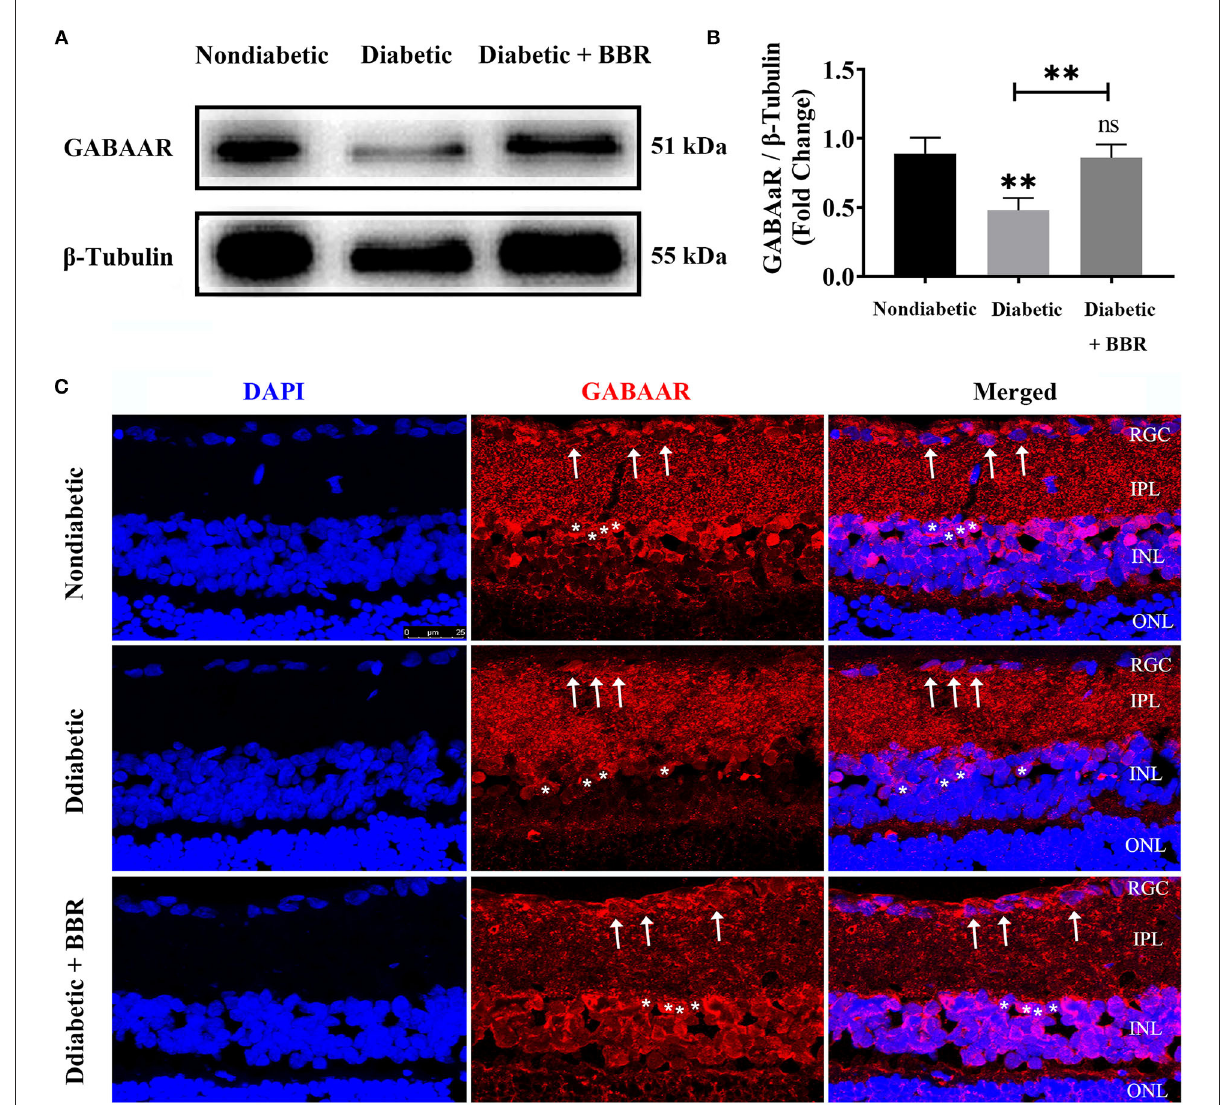
FIGURE2 Changes in GABA-alpha receptor expression in the retinas of the three groups. (A) Representative Western blots of GABA-alpha receptor expression in retinas of non-diabetic, diabetic, and diabetic + BBR + PBS groups. The expression of the 51 kDa protein was decreased in the diabetic group, and the decrease was reversed in the diabetic + BBR + PBS group with BBR administration. (B) Quantitative analysis of the GABA-alpha receptor confirmed the downregulation of GABAAR protein expression in diabetic retinas, and BBR treatment reversed the decrease in GABAAR (ns: no significant difference; ** P < 0.01; one-way analysis of variance). (C) Representative images of immunofluorescence staining of 10- µ m-thick frozen retinal sections from non-diabetic and diabetic rats treated with or without BBR. Fewer ganglion cells with red fluorescence in the retina were observed in the diabetic group (middle panel) than in the non-diabetic group (top panel). More red fluorescence was observed in retinas of the diabetic + BBR + PBS group than the diabetic group (scale bar, 25 µ m). The white arrows indicate RGCs; the asterisks indicate amacrine cells. BBR, berberine; GABAAR, GABA-alpha